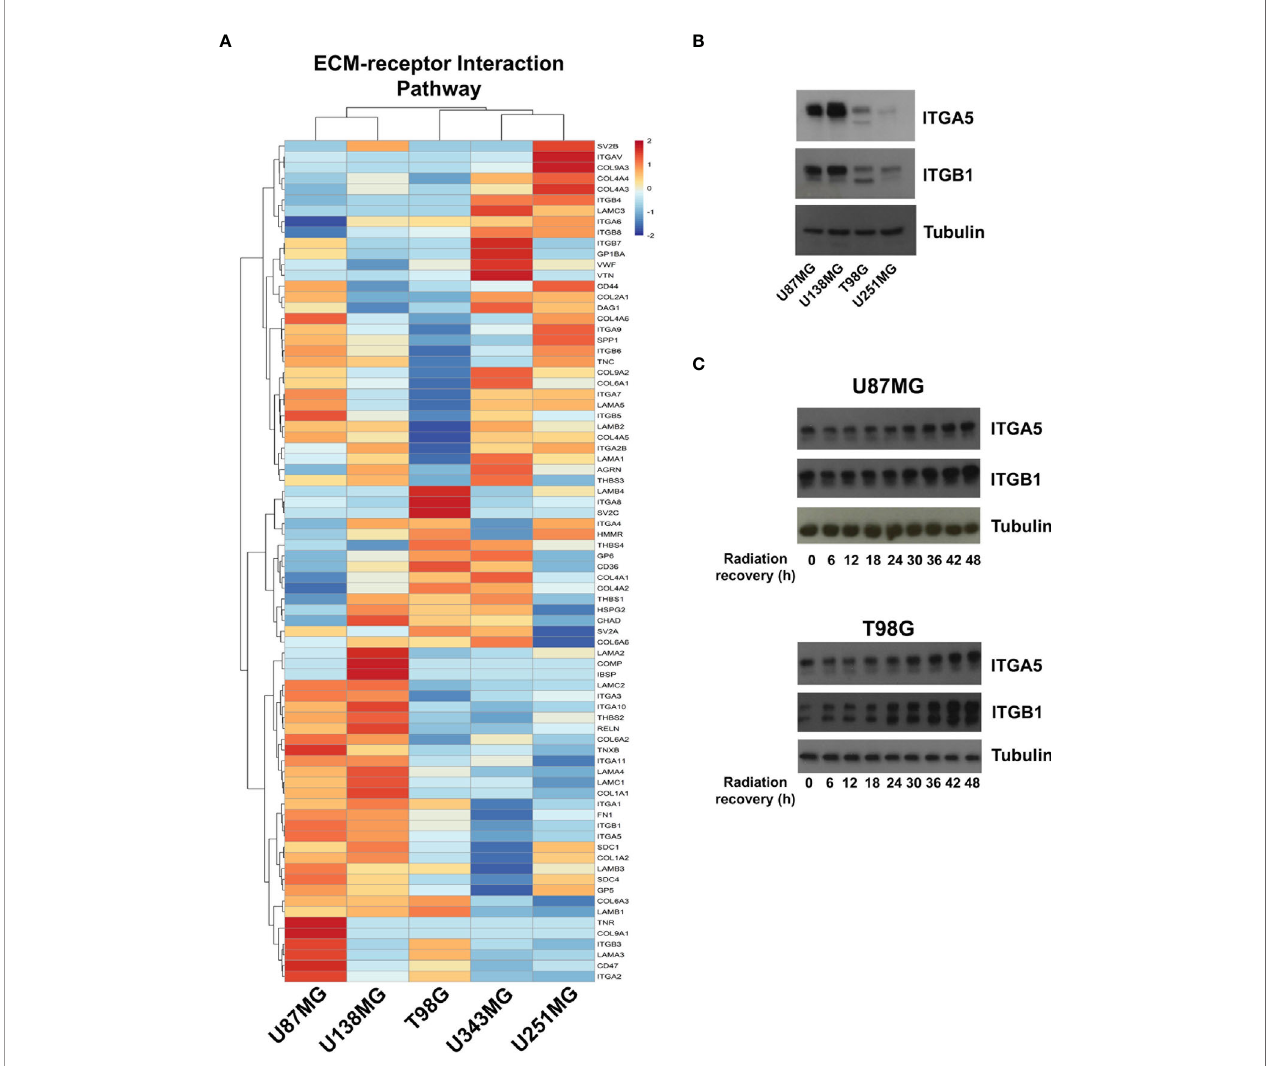
FIGURE 3 | Expression pro fi le of the ECM-receptor interaction genes in GBM cell lines. (A) Heatmap of the relative expression of genes enriched in the ECM- receptor interaction pathway, estimated expression in each GBM cell line relative to non-tumor astrocytes (ACBRI-371) are shown. (B) Western blot validating ITGA5 and ITGB1 expression in U87MG, U138MG, T98G, and U251MG cell lines. (C) Protein samples were collected 0, 6, 12, 18, 24, 30, 36, 42, and 48h after irradiation treatment with 10 Gy and the ITGA5 and ITGB1 protein levels assessed by western blot. The two bands detected for these integrins correspond to the precursor (upper band) and mature (lower band) forms of the protein, and variations are commonly observed depending on the cell line